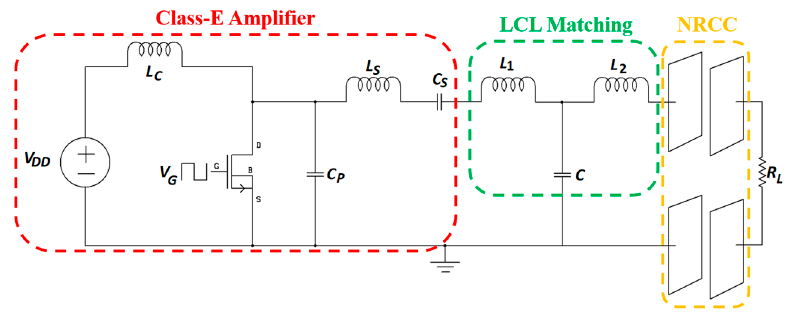
Figure 3. NRCC WPT system [59].